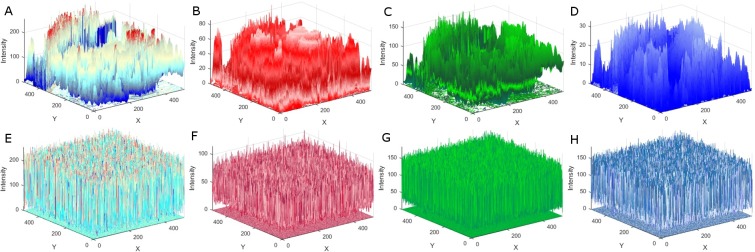
Three dimensional color intensity histograms of Parrot image of size 512×512.(a) 3D plain image histogram. (b) Red component histogram in 3D. (c) Green component histogram in 3D. (d) Blue component histogram in 3D). (e) 3D Encrypted image histogram. (f) Encrypted Red component histogram in 3D. (g) Encrypted Green component histogram in 3D. (h). Encrypted Blue component histogram in 3D.